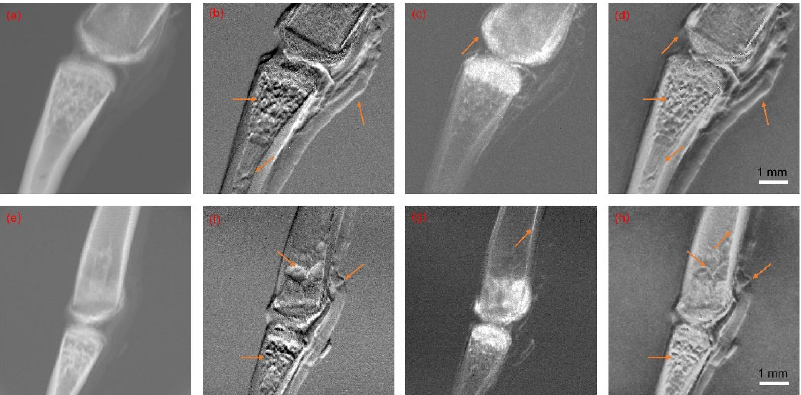
Figure 4. Source images and fusion results. ( a , e ) Source images from the AC channel; ( b , f ) source images from the DPC channel; ( c , g ) source images from the DFC channel; ( d , h ) fusion results by NSCT-SCM. The orange arrows point out distinct differences between tri-contrast modalities.